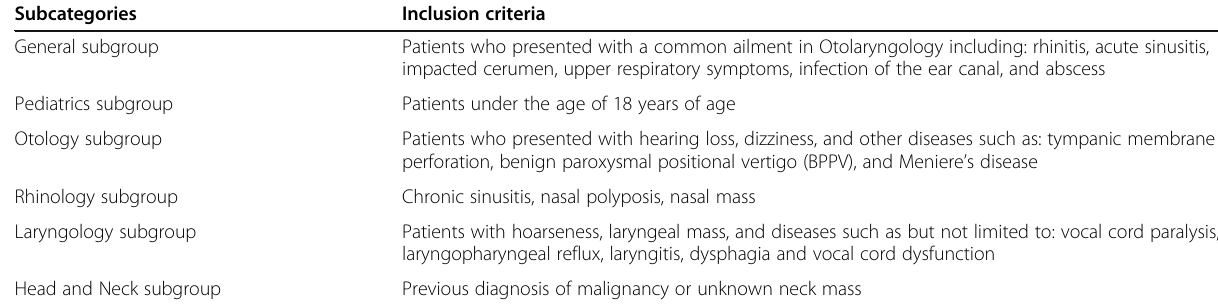
Table 1 Criteria for the Subcategories for patients who presented at the outpatient Otolaryngology department Subcategories